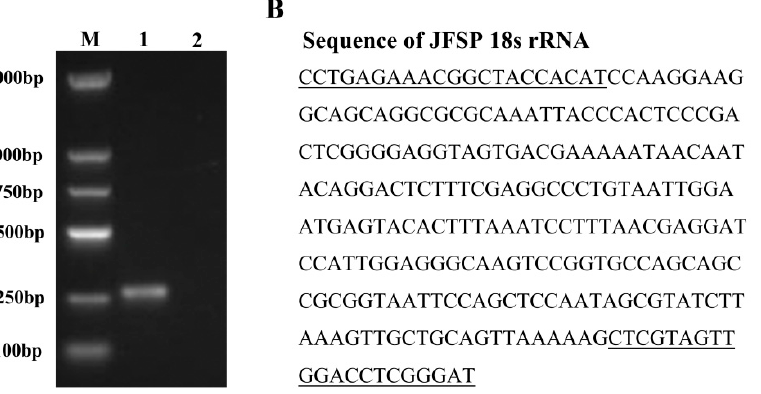
Figure 2. Agarose gel electrophoresis of PCR products from JFSP cells using specific primers for 18s rRNA. M, 2000 bp DNA maker; lane 1, 18s rRNA; lane 2,